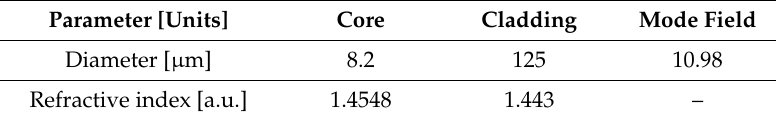
Table 1. Parameters of applied standard telecommunication fiber.